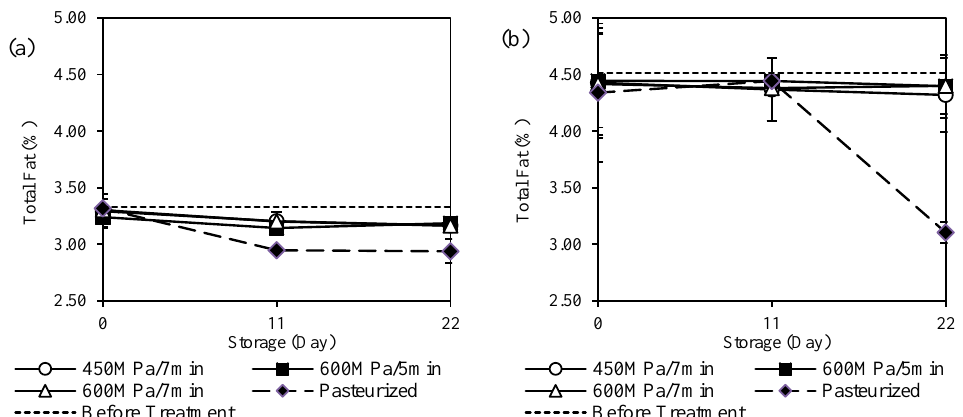
Figure 5. Changes in total fat of ( a ) cow and ( b ) goat milk during storage period of 22 days. Solid lines represent HPP-treated milk (450 MPa/7 min, 600 MPa/5 min, 600 MPa/7 min), dashed lines represent pasteurized milk, and dotted lines represent fresh milk before treatment.